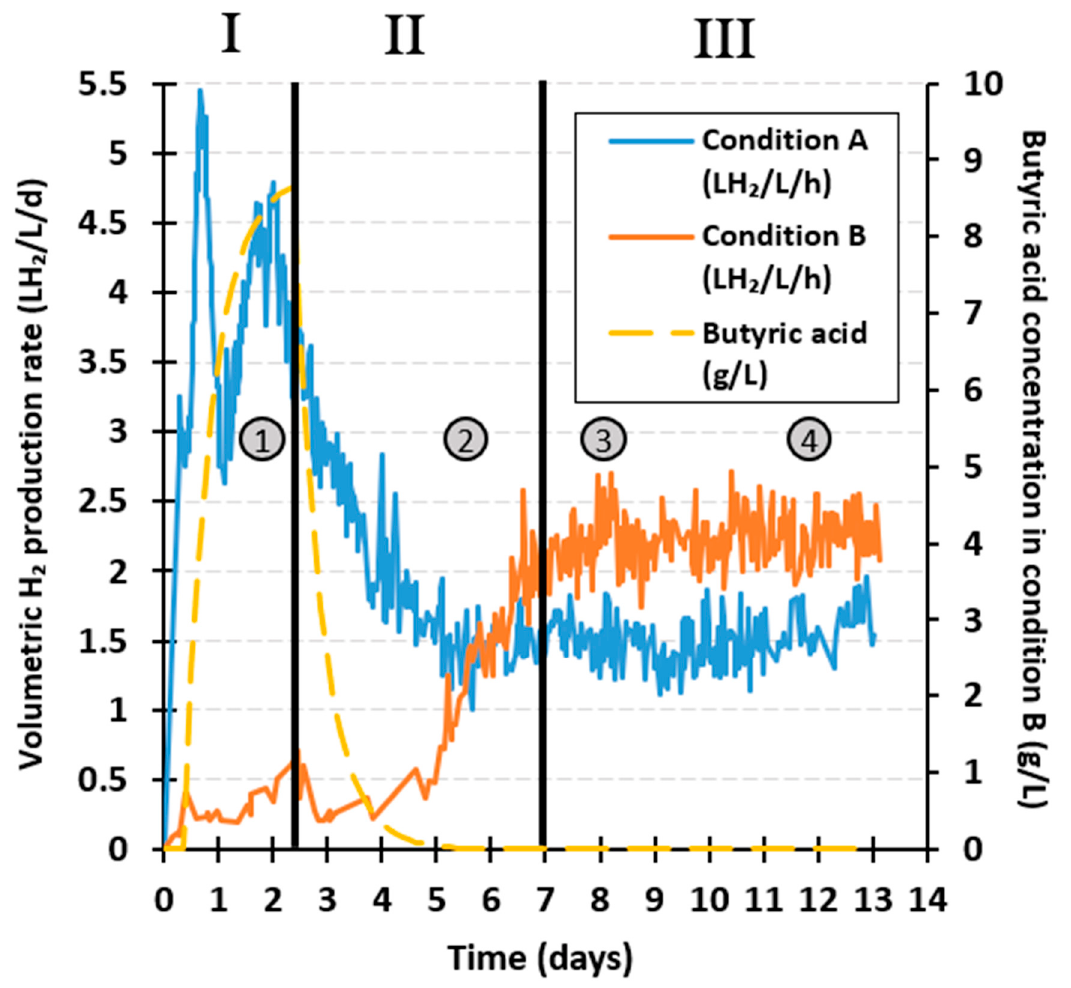
Figure 2. Volumetric H 2 production rate and exogenous butyric acid concentration in condition B (yellow dashes) during the stress period ( I ), the transitionary period ( II ), and the steady-state ( III ), respectively. The four samples used for microbial community characterization in conditions A and B are represented in black circle filled in grey to indicate their time of